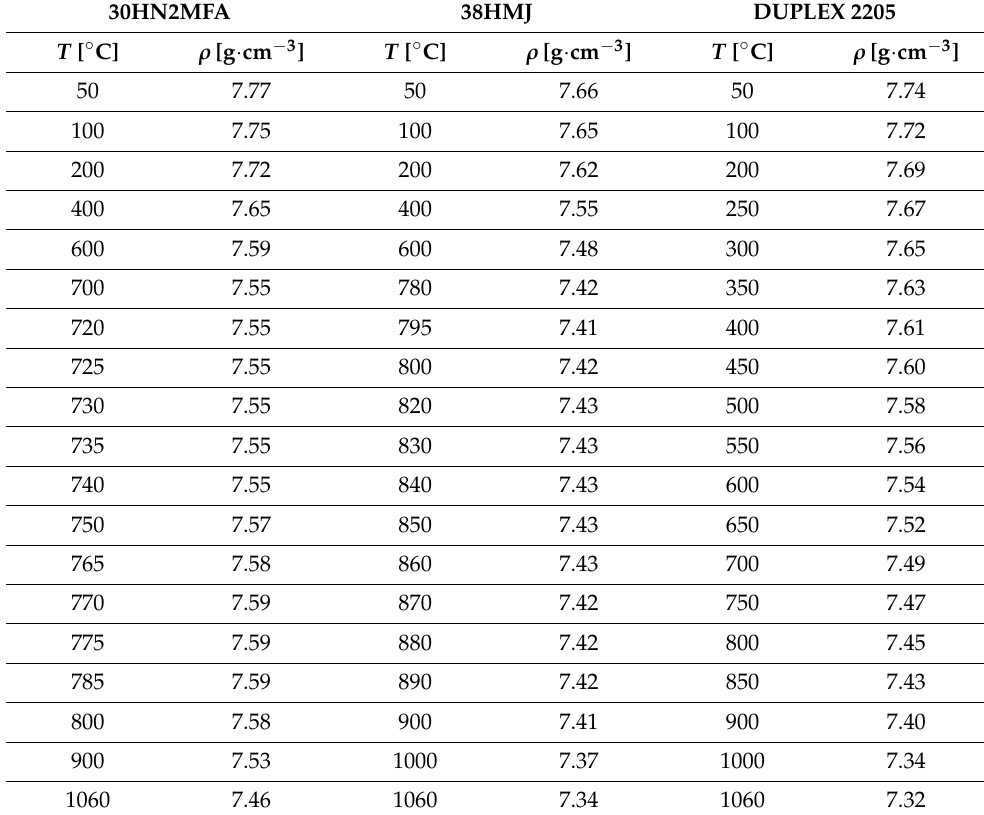
Table 4. Data on density of selected barrel steels